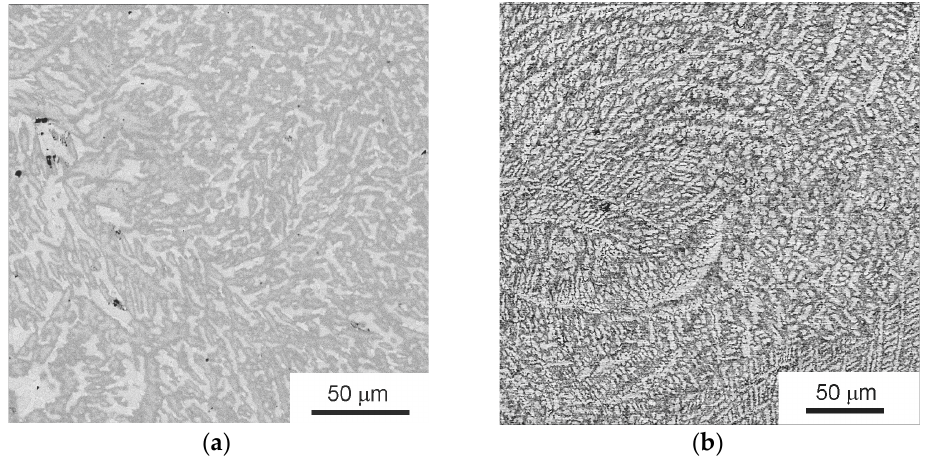
Figure 5. SEM images of the microstructure of the TiZrHfMoCrCo alloy annealed at: ( a ) 800 °C for 336 h and ( b ) 600 °C for 480 h.